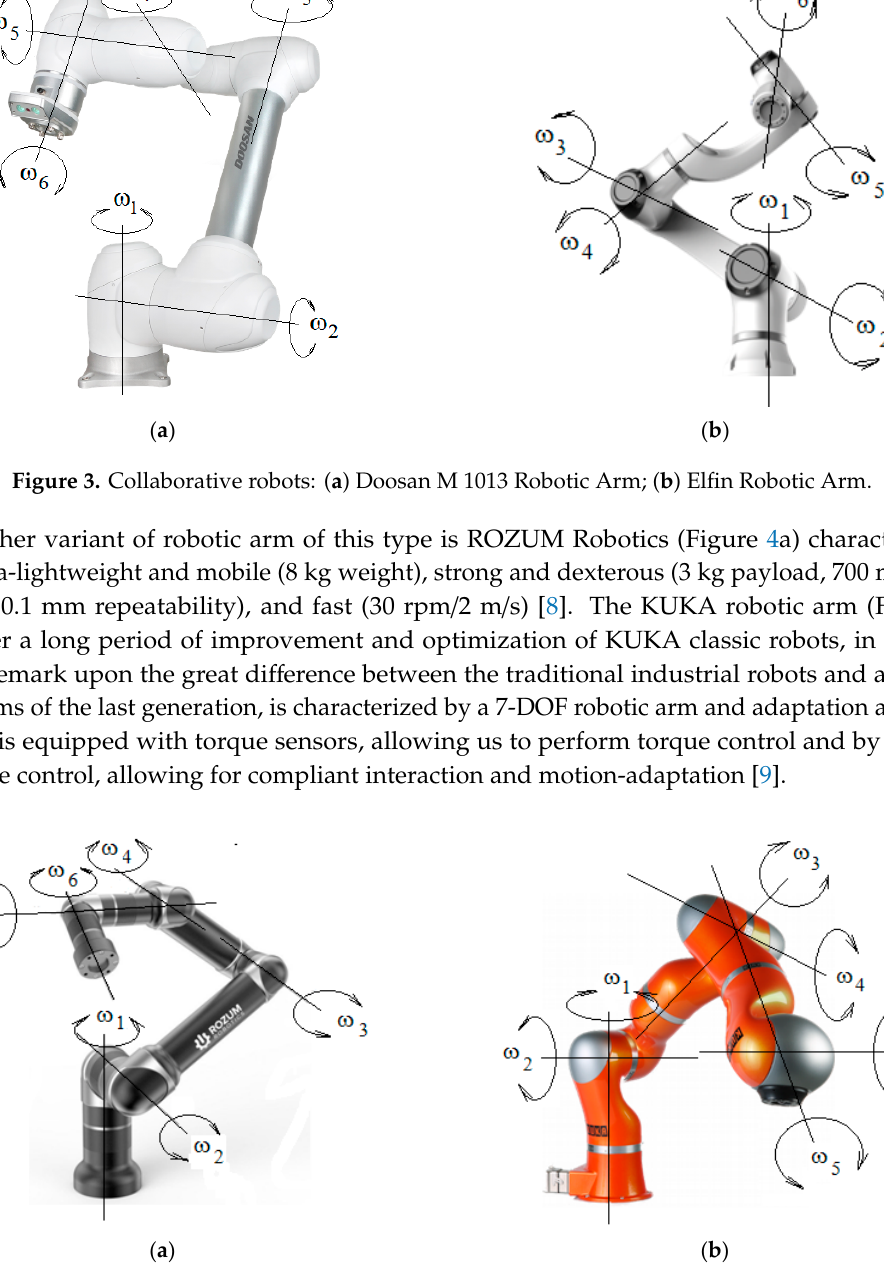
Figure 4. Collaborative robots: ( a ) ROZUM robotic arm; ( b ) KUKA robotic arm.